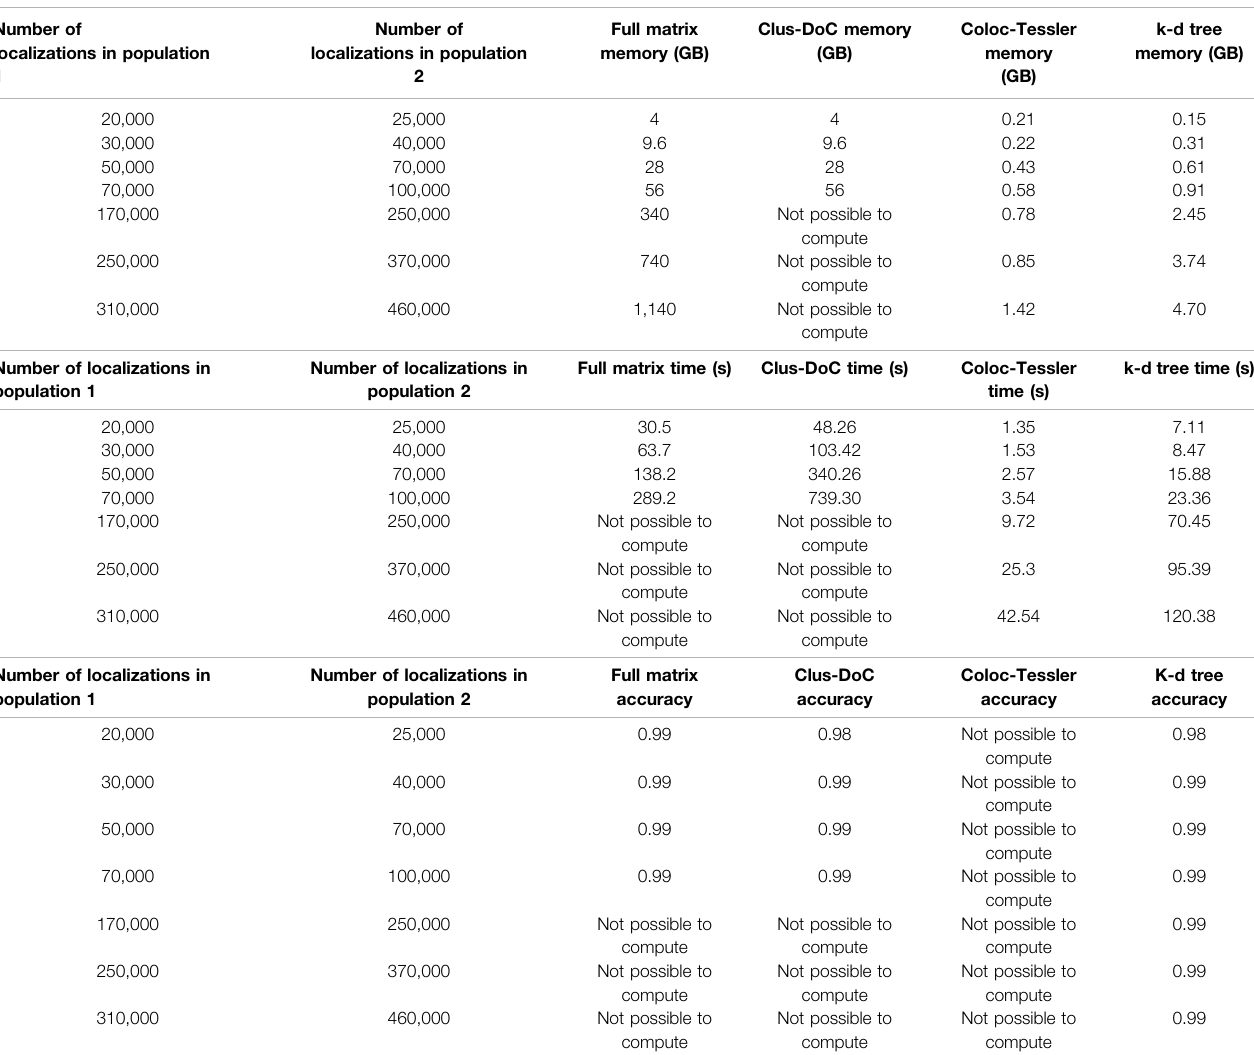
TABLE 1 | Performance Comparison of existing methods. This table compares our proposed kd-tree approach to three existing approaches, Clus-DoC, Coloc-Tesseler, and full matrix approach. Clus-DoC utilizes Ripley ’ s K analysis and density based clustering using DBSCAN to segment localizations into clusters and separate colocalizedfromnon-colocalizedclusters.Coloc-TesselerusesVoronoitessellationstoassesswhethermoleculesarecolocalizedandusesthetessellationdiagramtodraw boundariesaroundcolocalizedclusters.Datasetsweresimulatedinasimilarmannertothoseshownin Figure2 anddescribedinthemethodssection. Timewasmeasured astheentiretimerequired torunprogramafterdata fi les wereload.AnF-score(describedinthemethods section)wasused tocomparecolocalization accuracyamong alldatasets. SincelocalizationlistscannotbeoutputtedfromColoc-Tesseler,thecolocalizationaccuracyofthismethod cannotbecalculated.Furthermore,duetolarge memory requirement, Clus-DoC and the full matrix method cannot analyze datasets above 94 GB. Memory use by Coloc-Tesseler was estimated from task manager since it is a GUI based executable program with no available source code but all simulated molecule lists could be analyzed in an ef fi cient time window (seconds) while only requiring between 0.2 and 1.5 GB of